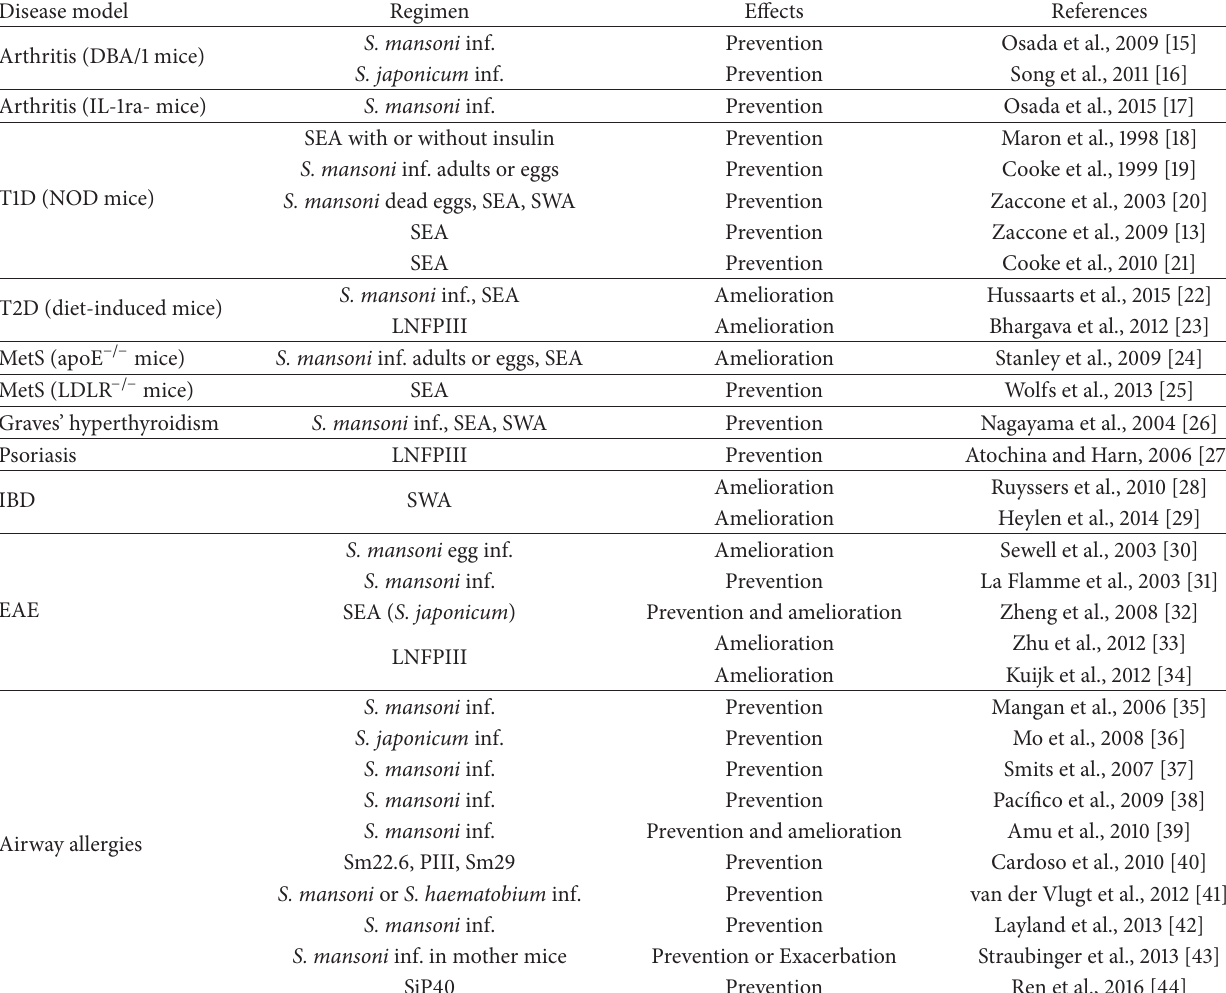
Table 1: Experimental animal models to study the role of schistosome molecules in different inflammatory and autoimmune